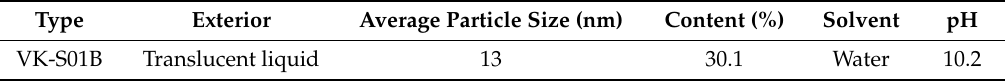
Table 3. General information of KIM waterproofing agent.